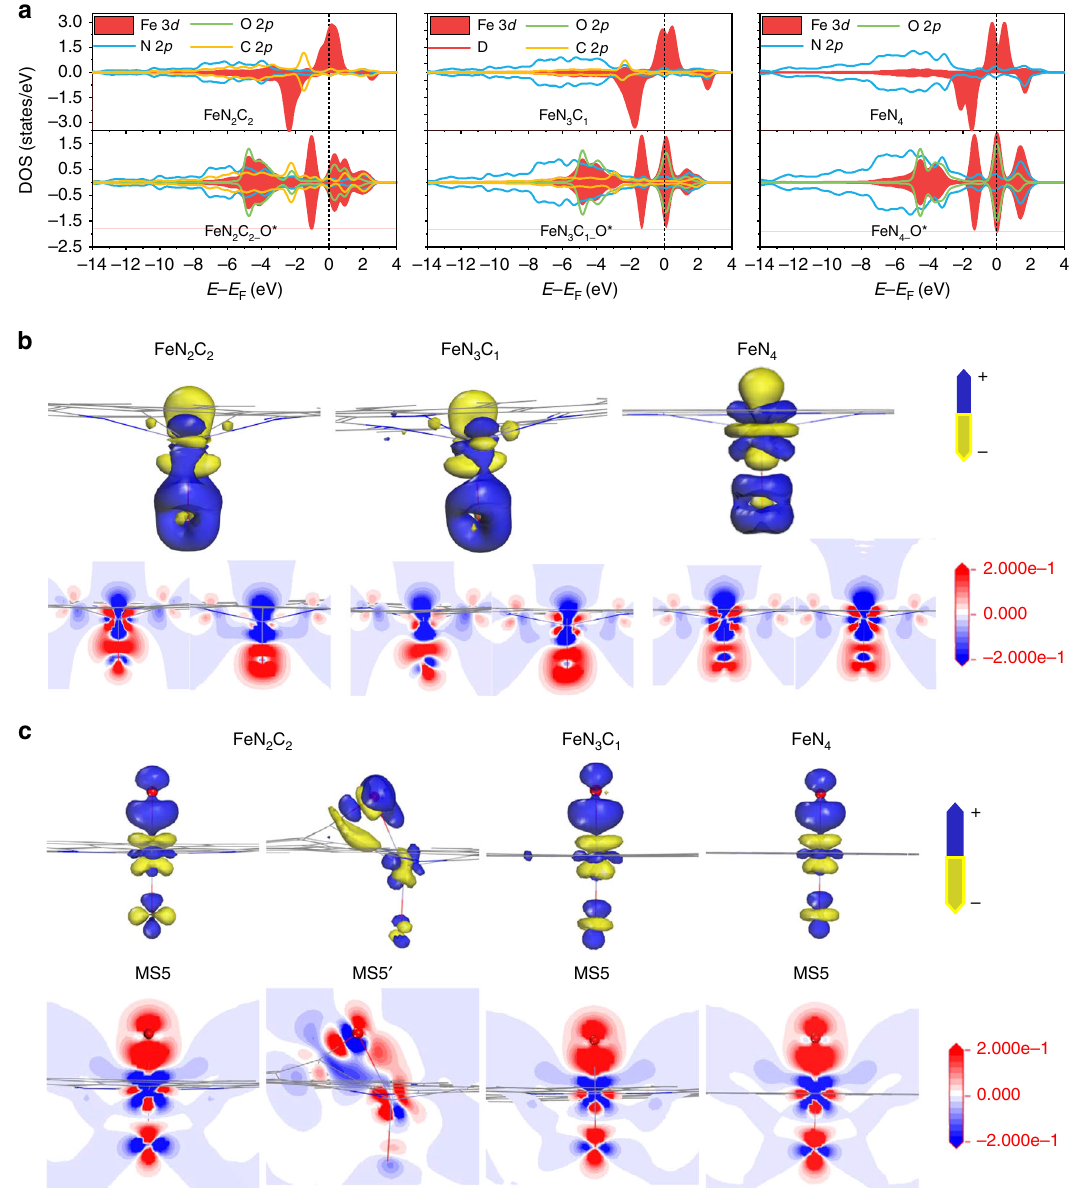
Fig. 6 PDOS and charge density differences analyses. a PDOS for the metal center, atoms in the fi rst coordinate shell and oxygen in Fe = O species (EF is marked in each graph with the black dash line). b , c Calculated charge density differences of b Fe = O and c O = Fe = O on Fe-N x C y ( x = 2, 3, 4 and related y = 2, 1, 0 from left to right) SAs/N-C catalysts (the characteristics of each color should be demarcated by the scale on the The 3D map (upper) and 2D pro fi le (below) of the charge density differences of O = Fe = O on Fe-N x C y , were shown Fig. 6c. In 2D pro fi le of O = Fe = O, the three panels (from left to right),